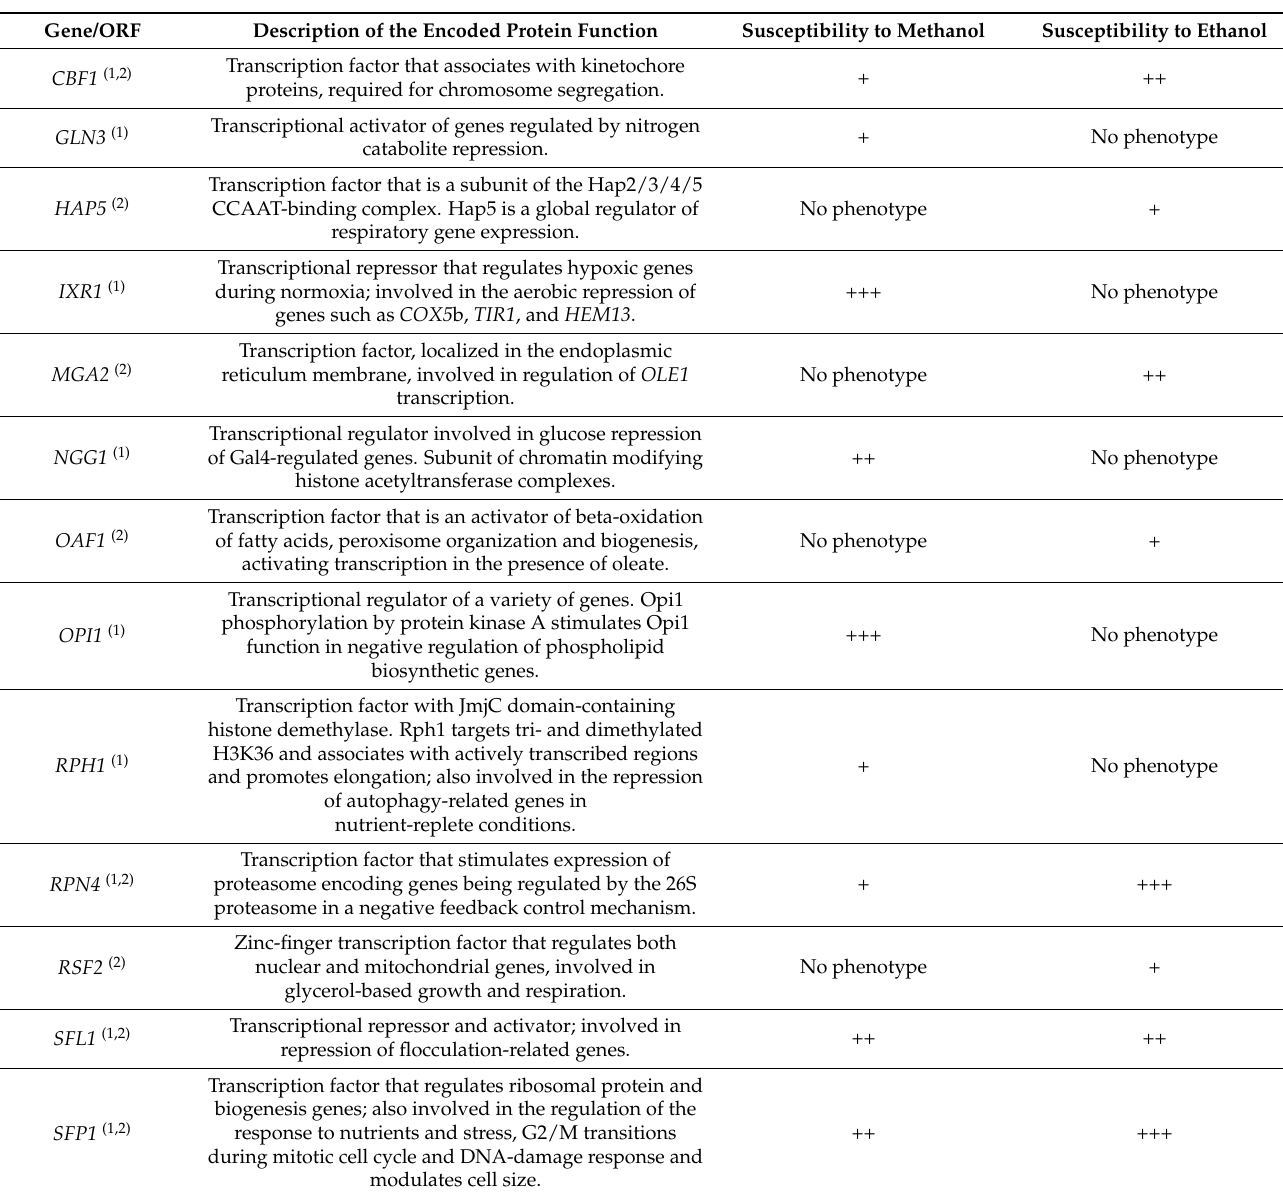
Table 6. Transcription factors (TF) identified only in the methanol dataset (1) , the ethanol-specific TFs (2) , and the TFs shared between methanol and ethanol datasets (1,2) . Symbols are as in Table